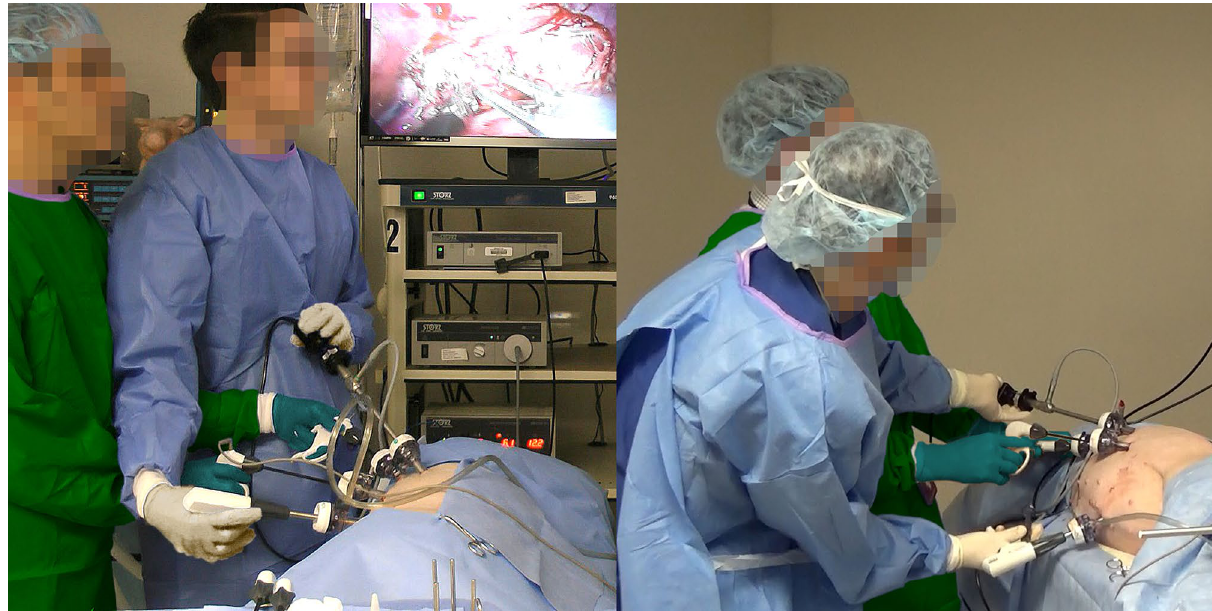
Figure 1. Candid photos of surgeon-assistant pairings performing porcine MIS with a standard laparoscope. Ergonomic posturing and ranges of motion are sacrificed to position the hand-held laparoscope at an appropriate viewing angle (note: gowns and gloves were re-colored using image processing software to ease differentiation between the limbs of the surgeons and assistants. Barring face pixilation, no additional image processing was